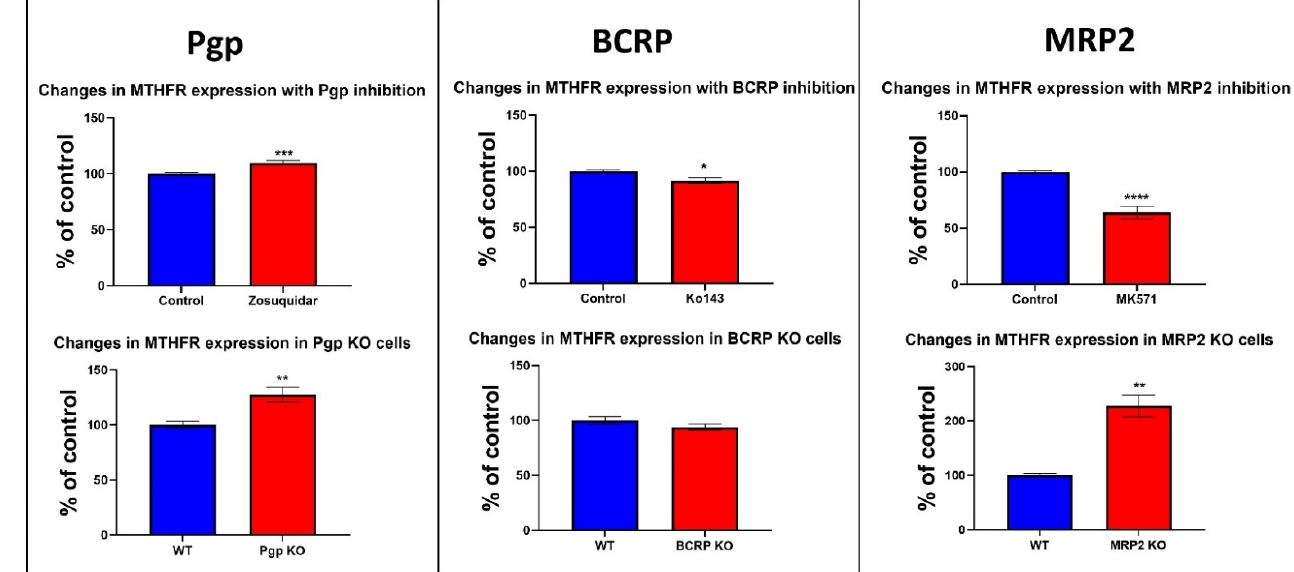
Figure 6. MTHFR expression in cells treated with zosuquidar (5 µM), Ko143 (10 µM) and MK571 (200 µM) and in Pgp KO, BCRP and MRP2 KO cells. Cells were incubated with zosuquidar, Ko143 and MK571 for 24 h, after which cells were lysed and protein was extracted. Then, 1.2 µg protein was loaded on WES instrument and vinculin was used as a loading control. The data are normalized against vinculin and represent the average of a minimum of 3 replicates from one experiment with KO cells and 3 independent repeats with the inhibitors. Blue bars represent control cells, and red bars represent treated/KO cells. Significance of these results was determined using un- paired Mann–Whitney test and results with * p < 0.05, ** p < 0.01, *** p < 0.001, **** p < 0.0001 were considered